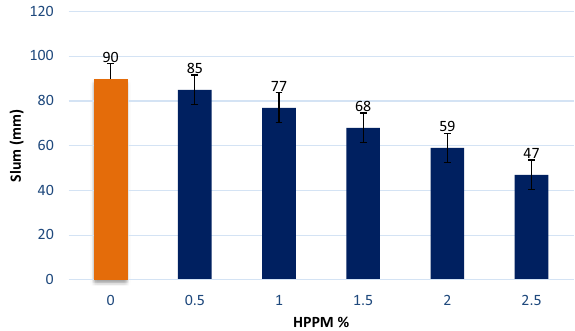
Figure 4. Slump values of different percentages of HPPM.